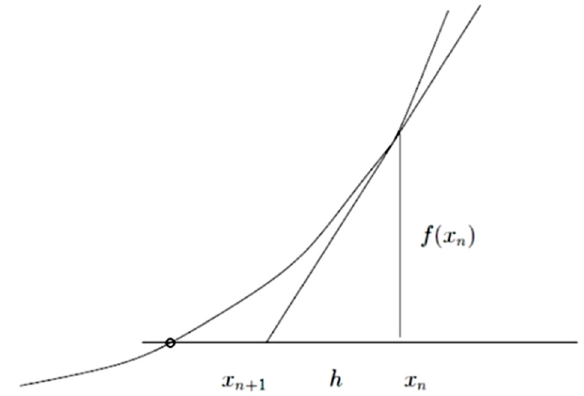
Figure 6. Graphical description of Newton-Raphson method.